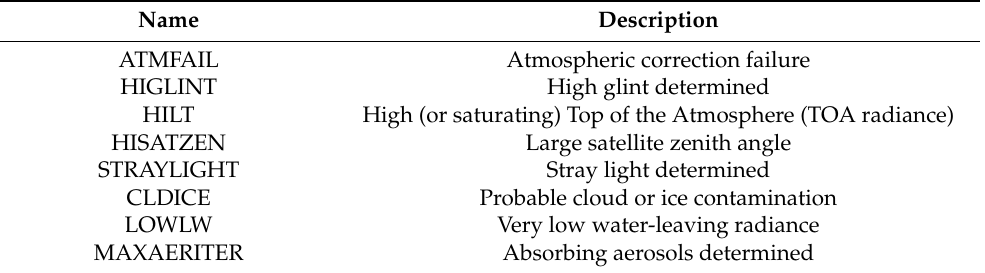
Table 3. Level 2 flags used for excluding pixels from analysis.